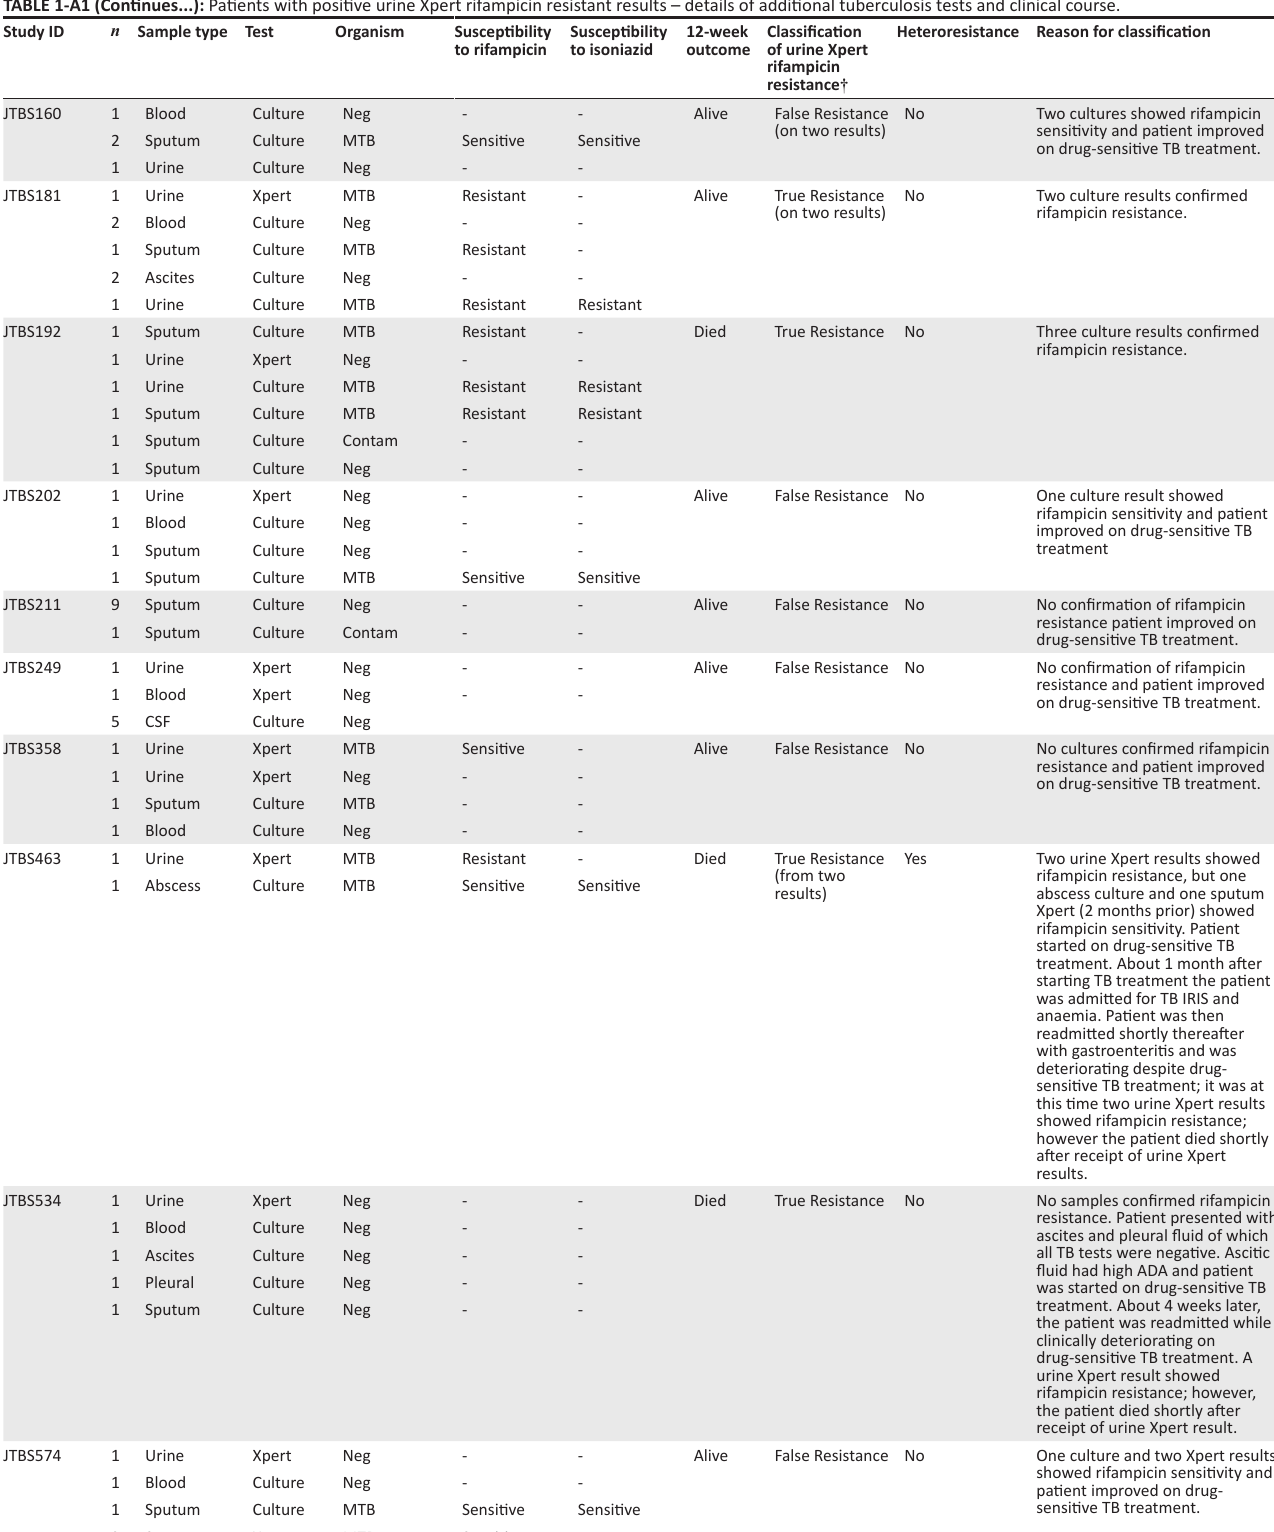
TABLE 1-A1 (Continues...): Patients with positive urine Xpert rifampicin resistant results – details of additional tuberculosis tests and clinical course. Study ID n Sample type